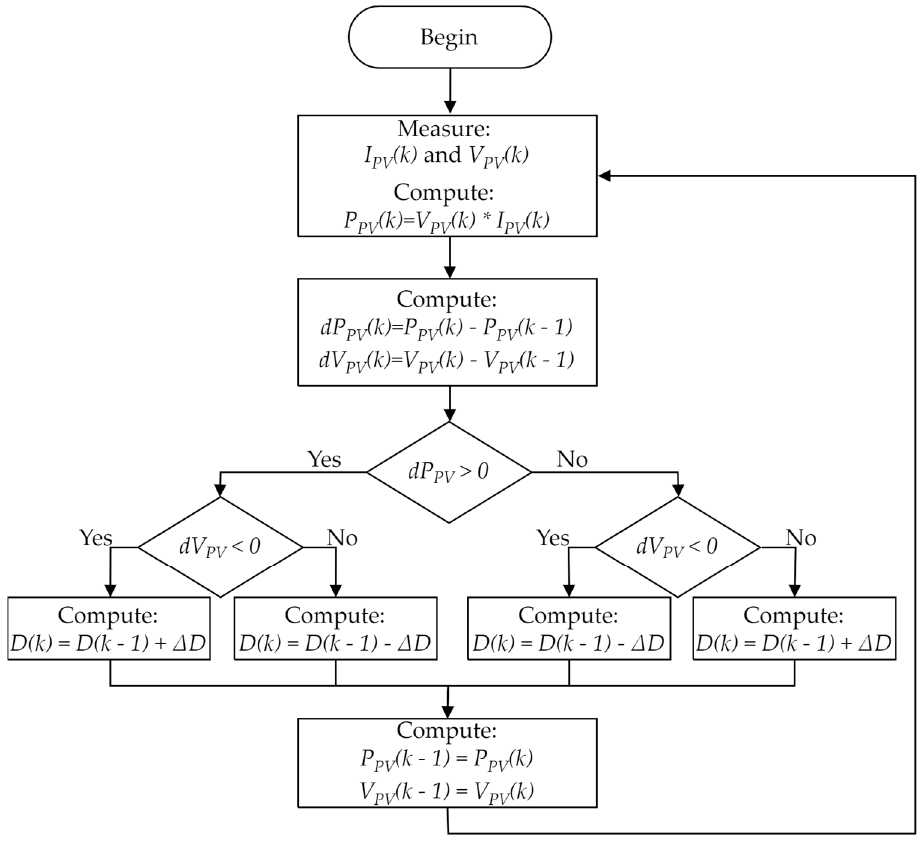
Figure 3. Flowchart of P&O algorithm.